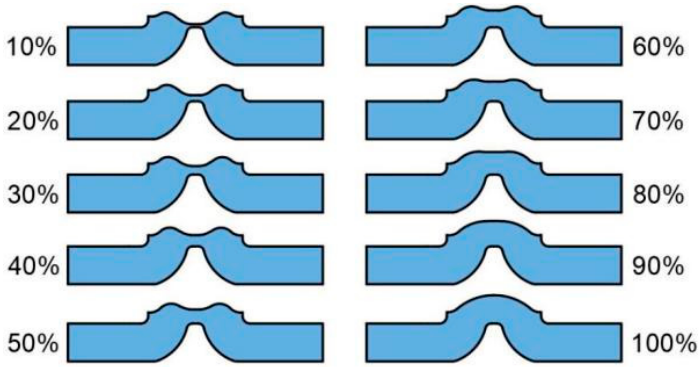
ff erent openings (profile